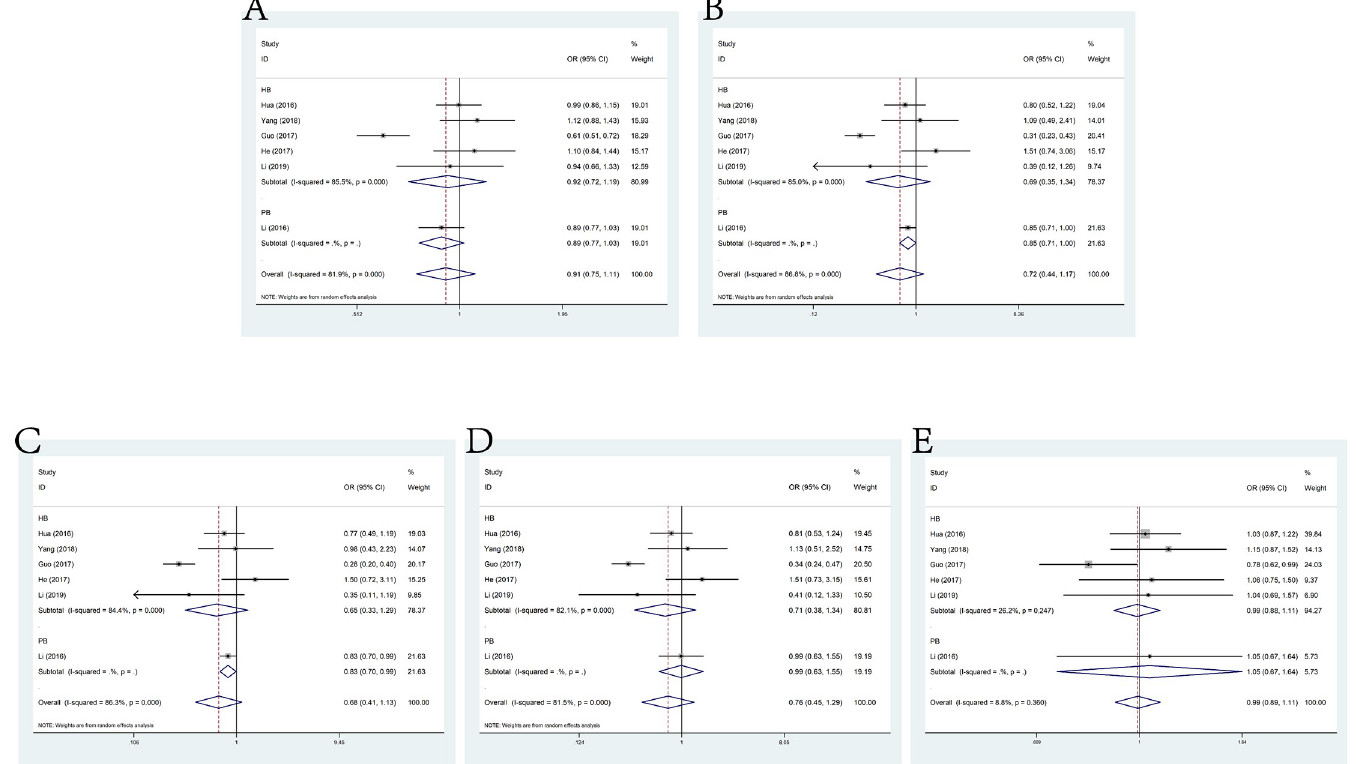
Fig 5. Forest plot of the association between H19 polymorphism rs2735971 A > G and cancer susceptibility. A: allele model; B: dominant model; C: heterozygote model; D: homozygote model; E: recessive model.